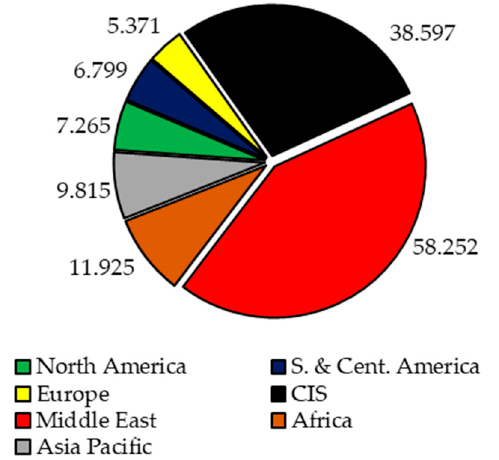
Figure 3. Proved natural gas reserves in thousand million barrels based on data reported by BP, 2020.